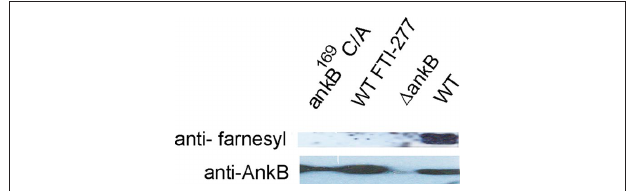
FIguRe 4 | Ankyrin B is modified by the host cell farnesylation machinery. D. discoideum were infected with the L. pneumophila strains. The infection was performed for 1 h and the cells were examined at 2 h post-infection. The AnkB proteins were immunoprecipitated from semi- purified LCVs using anti-AnkB antibodies and then analyzed by immunoblotting with anti-AnkB and by anti-farnesyl antibodies. The data are representatives of independent